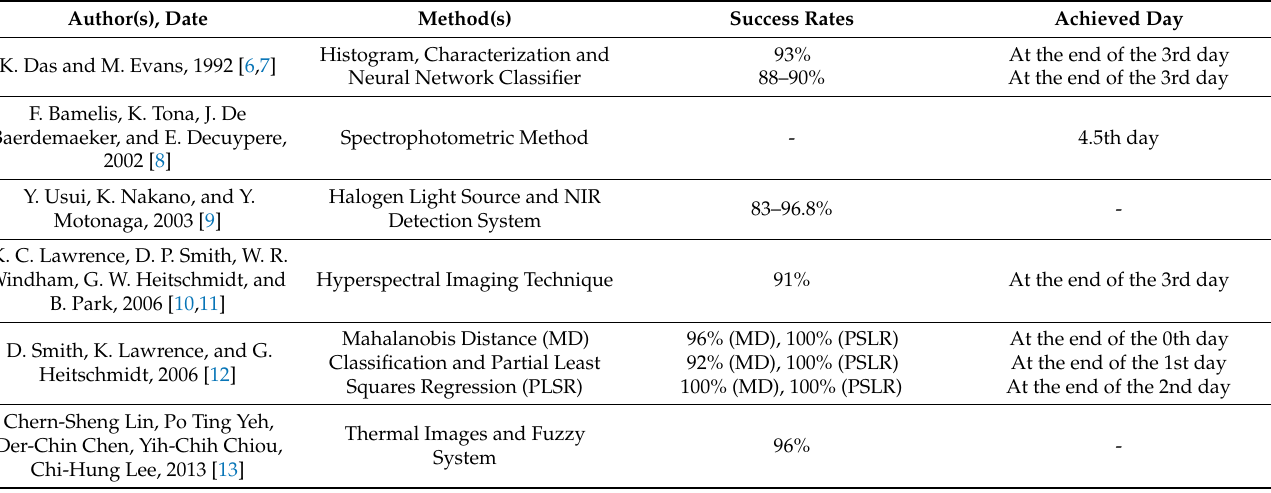
Table 1. Egg fertility control literature